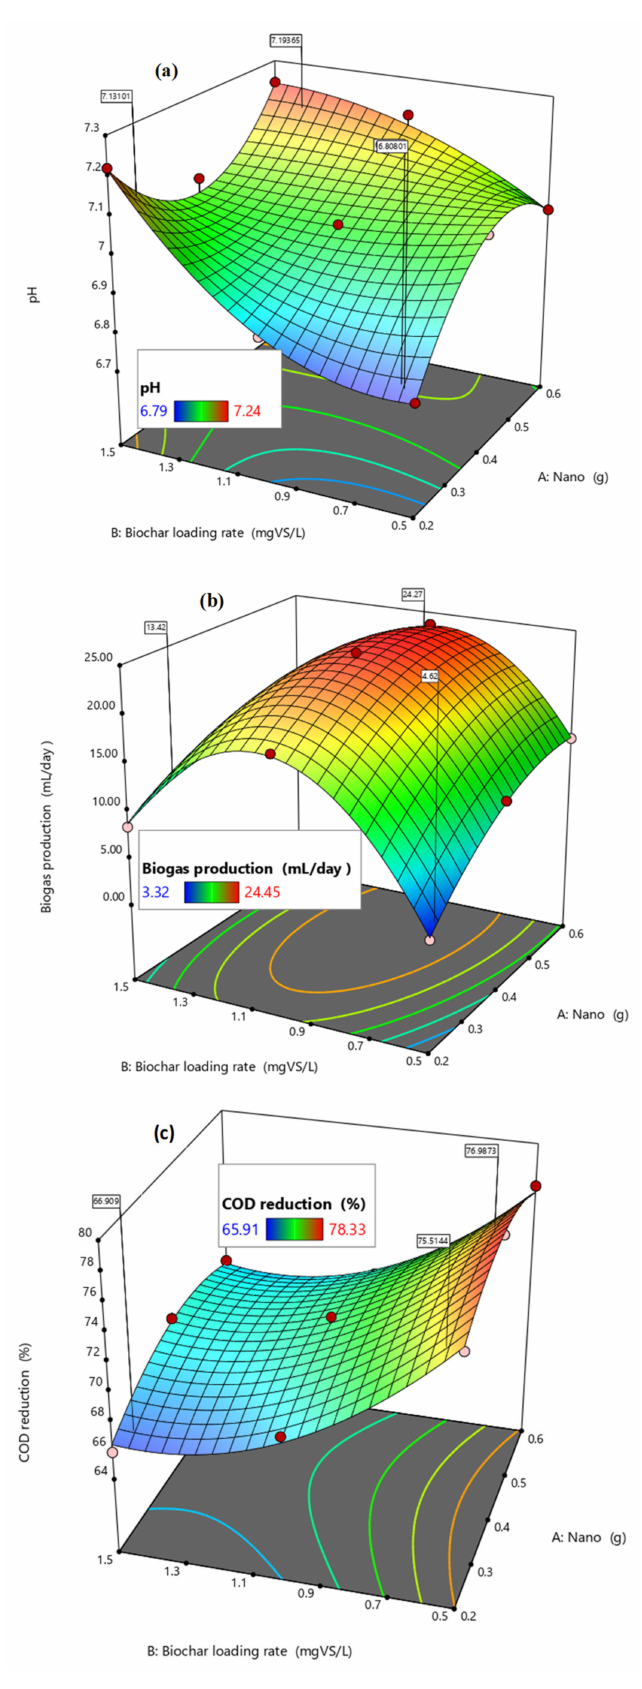
Figure 4. Three-dimensional (3D) response surface plots ( a ) pH, ( b ) biogas production, and ( c ) COD